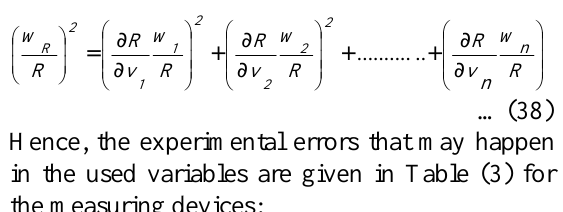
Table 3, Uncertainties of Measuring Tools. Independent Variables (V)